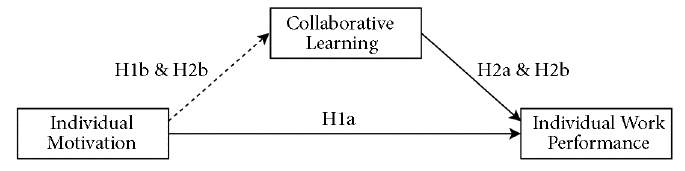
Figure 1. The conceptual